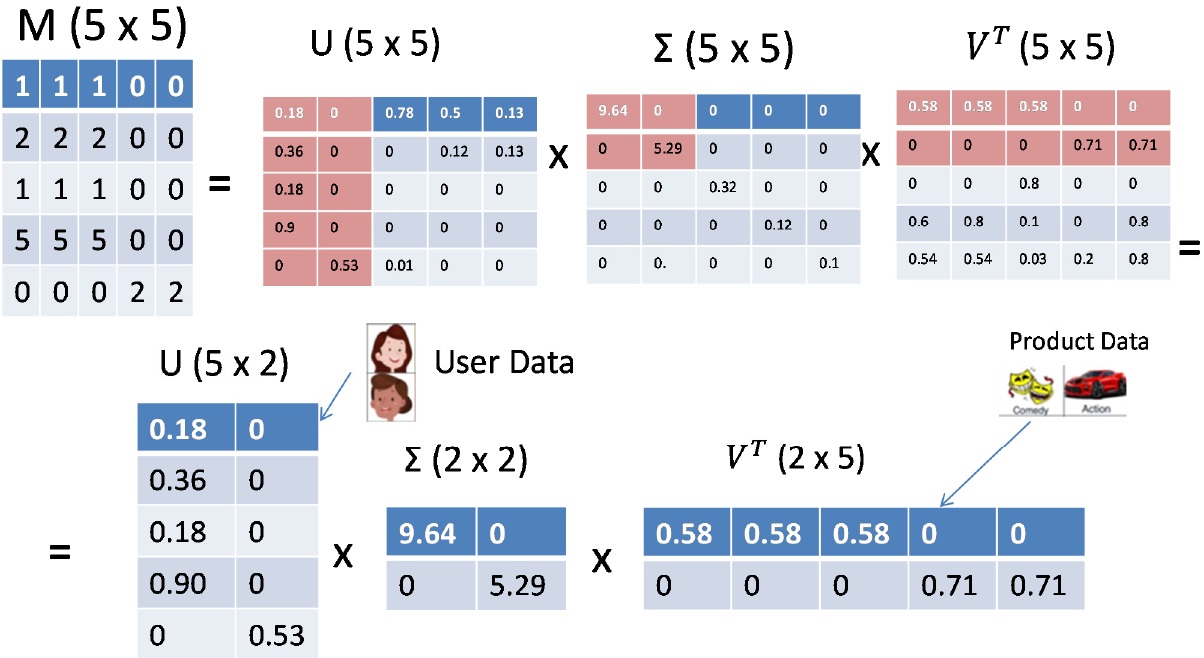
Figure 2. Singular Value Decomposition (SVD).